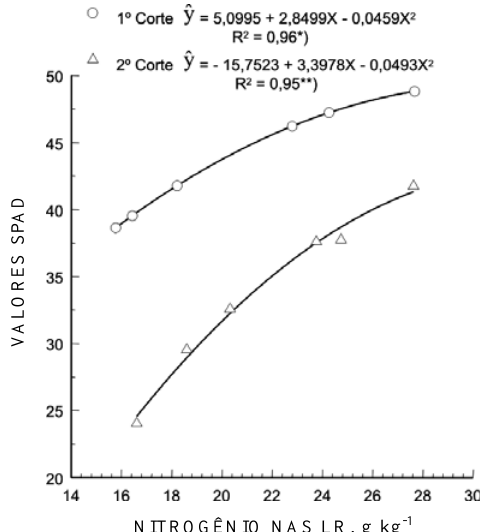
Figura 5. Relação entre as unidades de valor SPAD (Y) e a concentração de N nas lâminas de folhas recém-expandidas (LR) do capim-Aruana (X), no primeiro e segundo corte das plantas. Quadro 2. Quantidade acumulada de N nos componentes da parte aérea (FE, LR, LM e CB) no primeiro